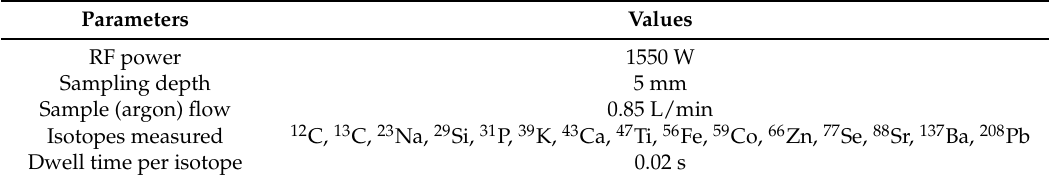
Table 2. Operation parameters for